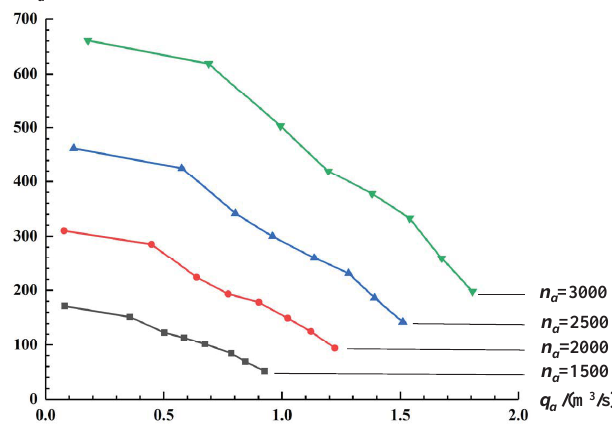
Figure 8. Pressure characteristics of the fan.